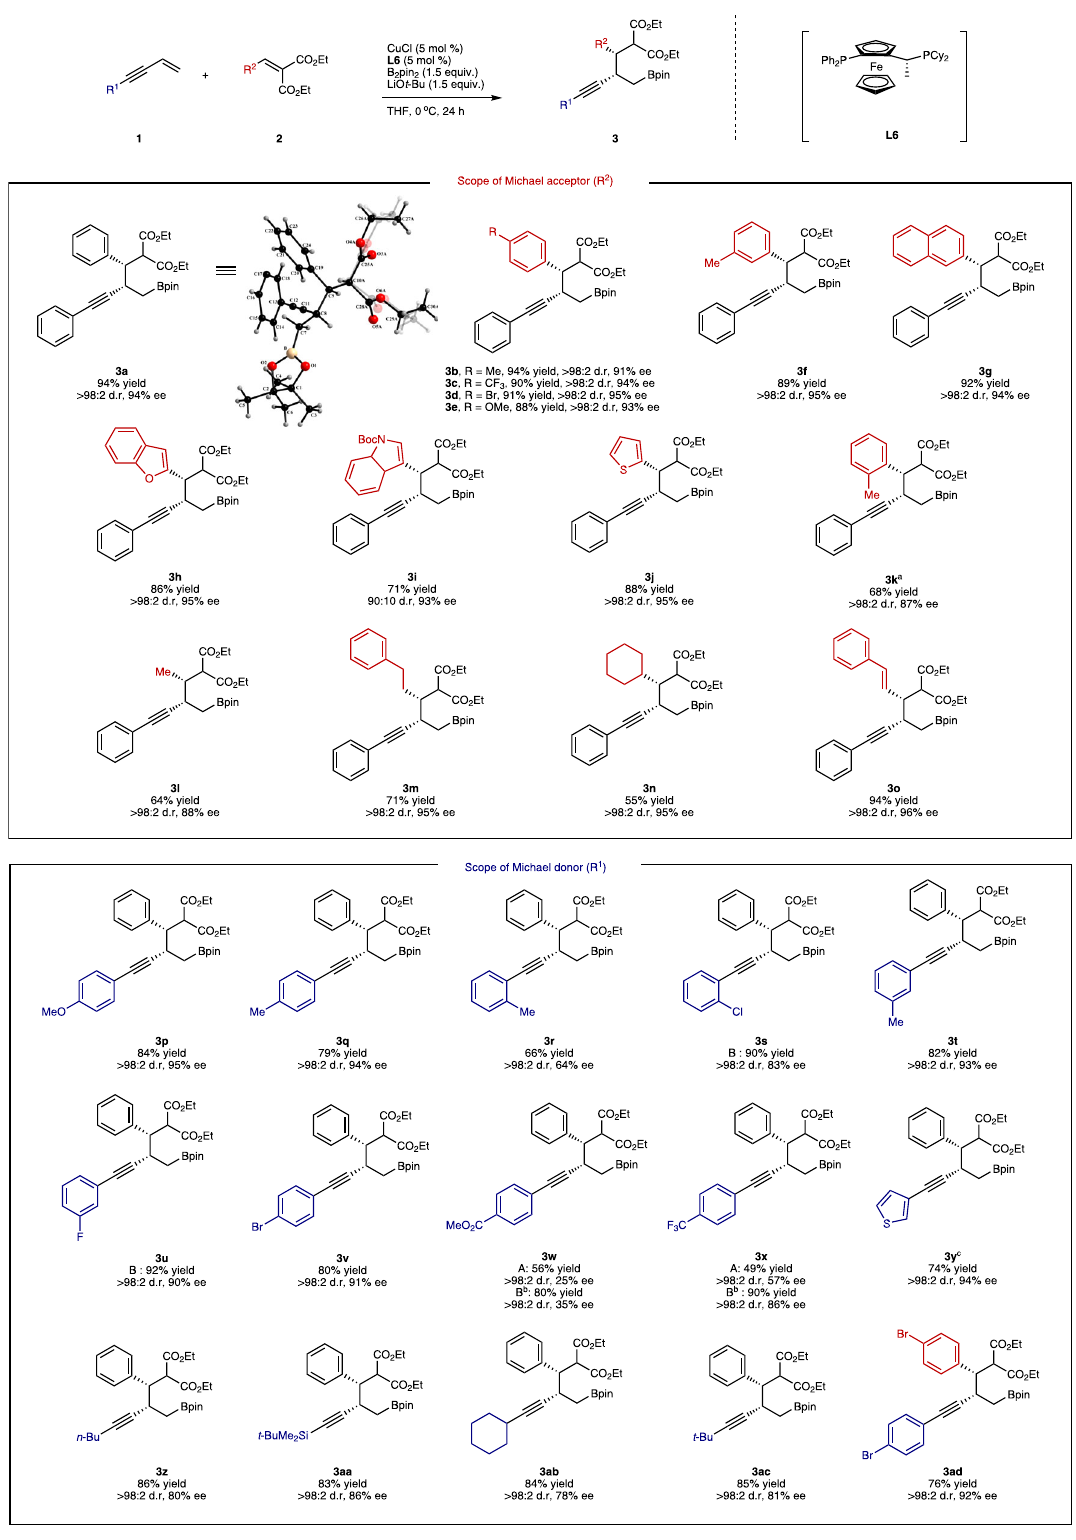
Fig. 3 Substrate scope of terminal enynes and alkylidene malonates. Reactions were generally conducted in a 0.5 mmol scale using 1 (1.5 equiv.) and 2 (1.0 equiv.) at 0 °C (condition A) unless otherwise noted. Under condition B, 1 (1.0 equiv.) and 2 (2.0 equiv.) were used at 0 °C. a The reaction was carried out at 40 °C. b The reaction was carried out in methyl tert-butyl ether (MTBE) instead of THF. c 1.5 equiv. of 2 was